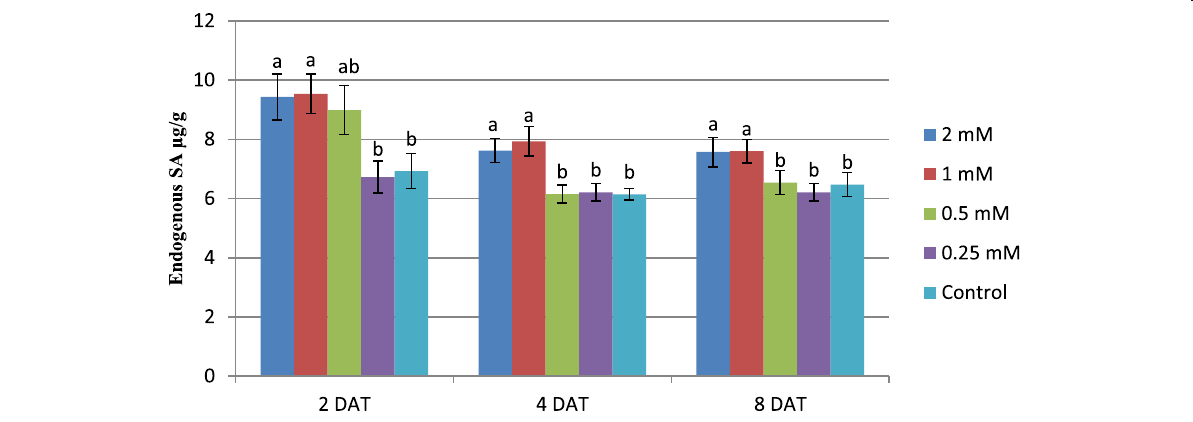
Fig. 1 Changes in endogenous SA over time in maize plants in response to their exogenous application at different levels